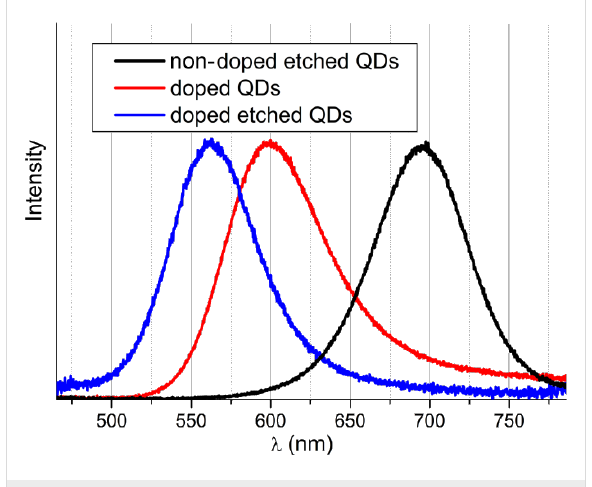
Figure 13: Normalized PL spectra of three samples: non-doped etched with HF, doped with Zn and etched with HF, and doped with Zn non-etched